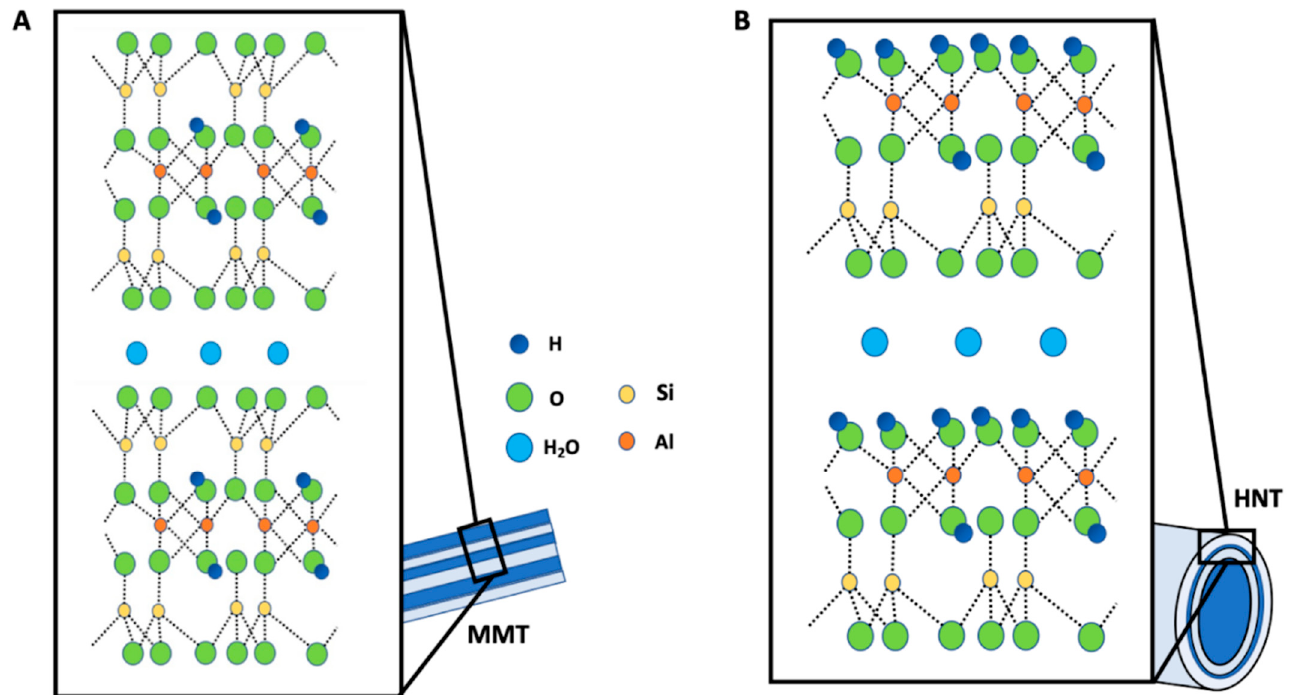
Figure 1. Chemical structures of MMT ( A ) and the HNT ( B ).